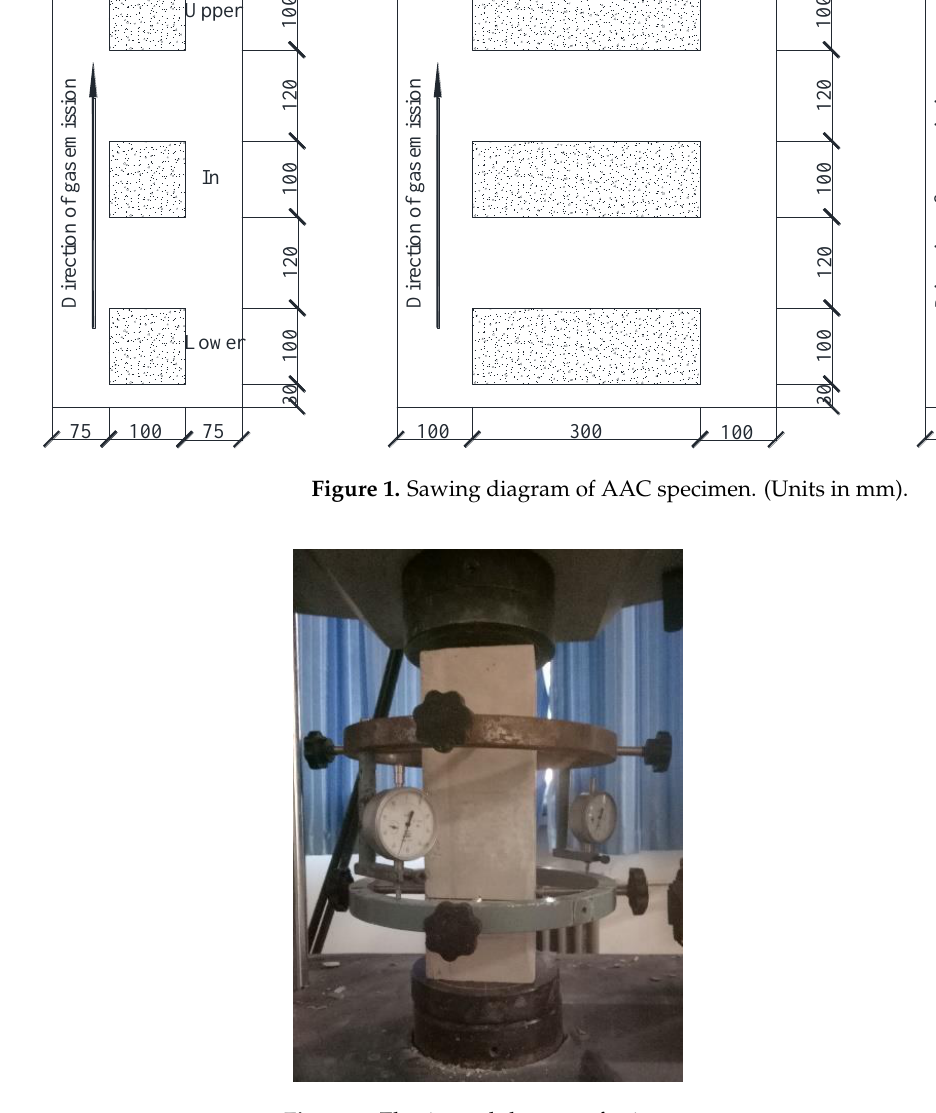
Figure 1. Sawing diagram of AAC specimen. (Units in mm)